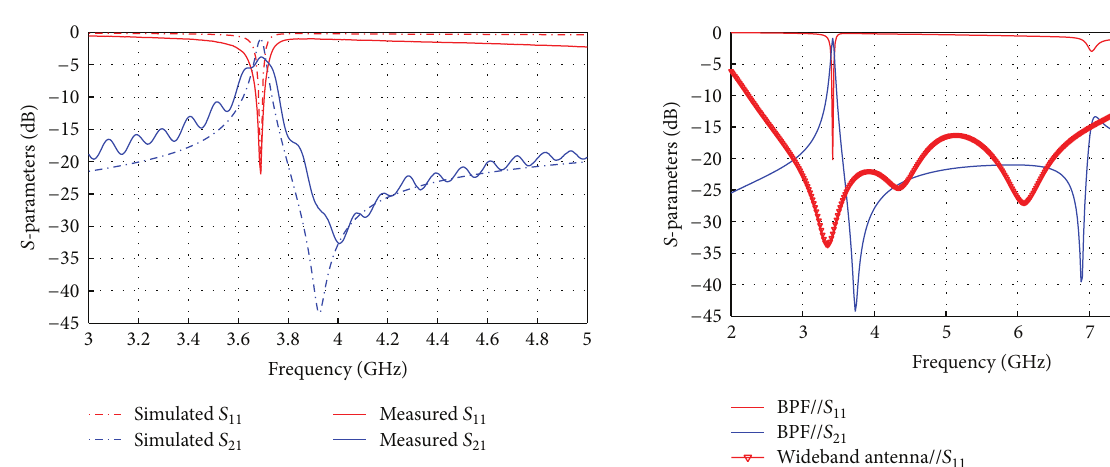
Figure 5: Computed 𝑆 -parameters of the OLR-based bandpass filter and the wideband antenna.